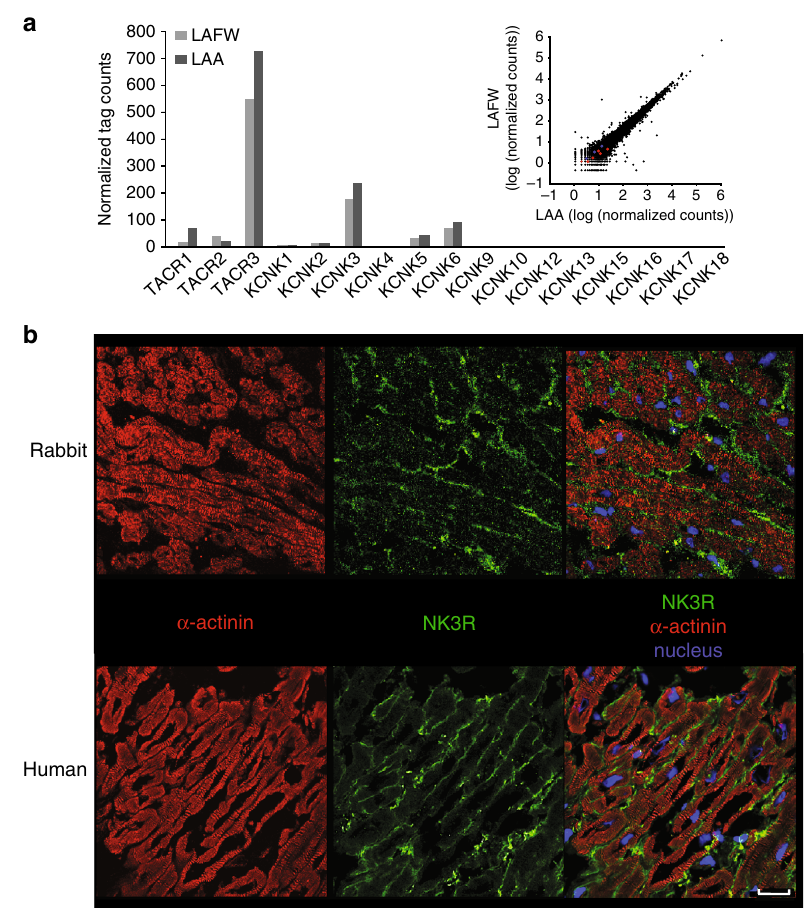
Fig. 5 Expression of the NK-3 receptor and KCNK gene family in left atrium of rabbit and human. a Bar graph showing the normalized tag counts from RNA- seq for the TACR gene and KCNK gene family in the left atrial free wall (LAFW) and the left atrial appendage (LAA) of rabbit ( n = 1). Right inset: Scatter plot showing the relation between expression pro fi les of all genes in LAWF and LAA in rabbit. The blue and red dots indicate TACR and KCNK genes, respectively. b Sections of rabbit (upper panel) and human (lower panel) left atrium showing labelling of the NK-3R (green) in the peripheral sarcolemma of cardiomyocytes, co-stained for the intracellular myocardial marker a-actinin (red). Scale bar 25 µ M. Negative controls for immunohistochemistry are shown in Supplementary Figure